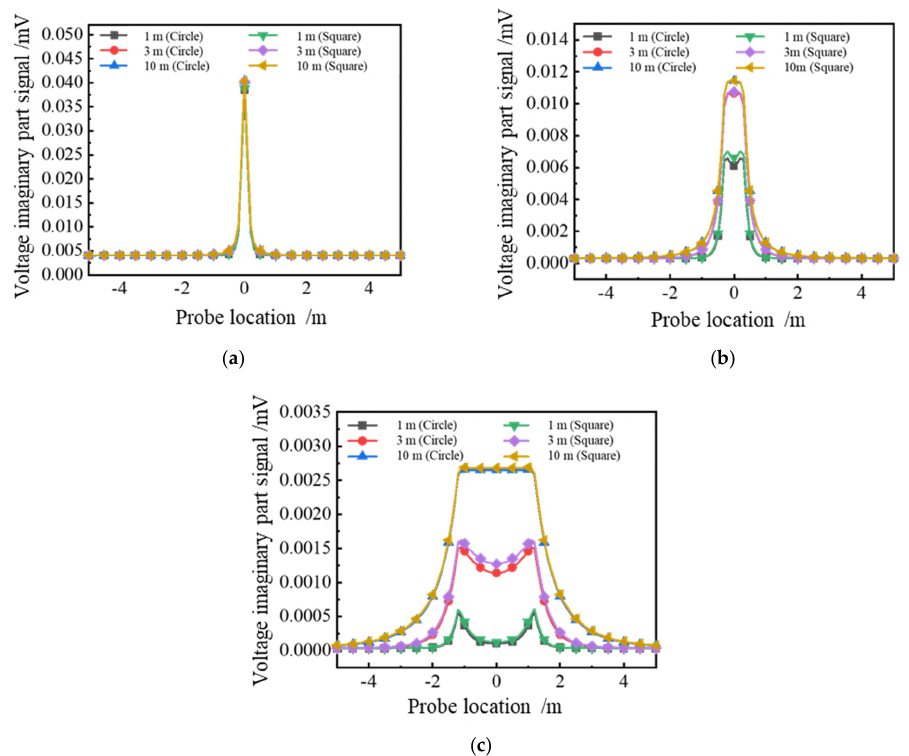
Figure 13. Voltage real part signal diagram between square fractures and circular fractures: ( a ) real part signal of subarray 1; ( b ) real part signal of subarray 4; ( c ) real part signal of subarray 7.